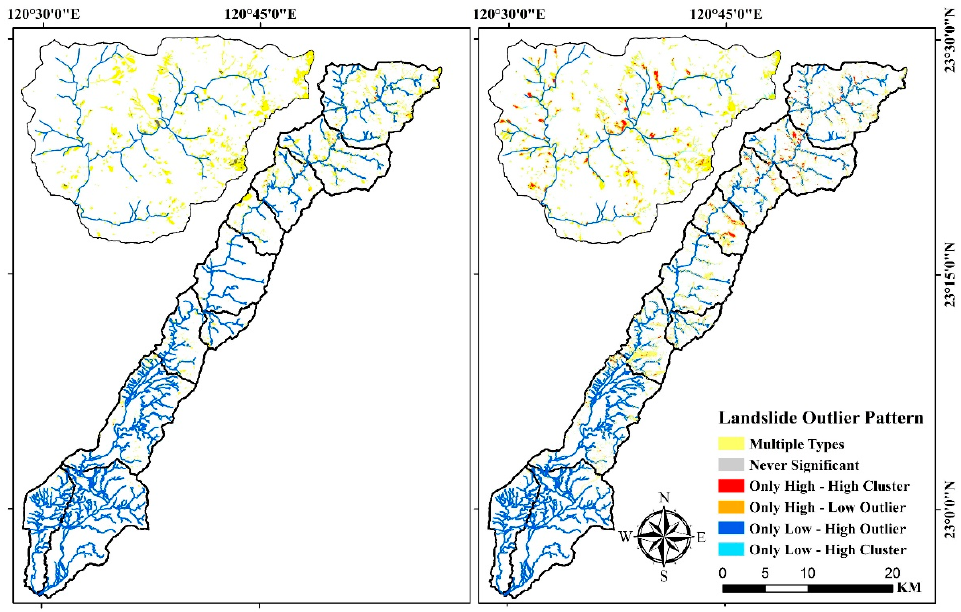
Figure 7. Local outlier analysis of landslide evolution during 1999–2008 ( left figure ) and 2008–2017 ( right figure ) in the Chishan river watershed.